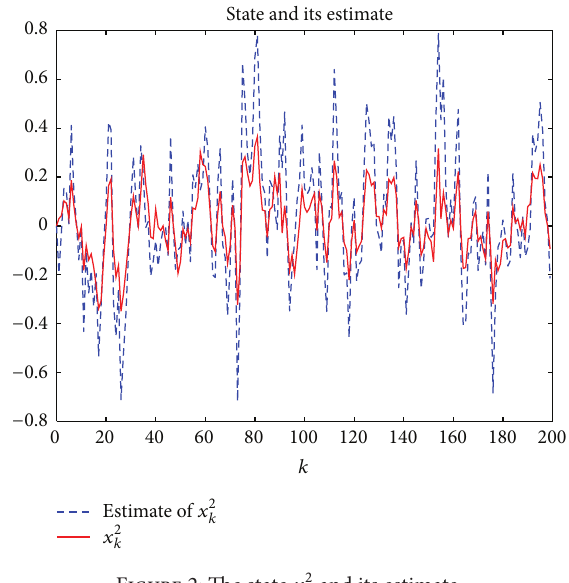
Figure 2: The state 𝑥 2 𝑘 and its